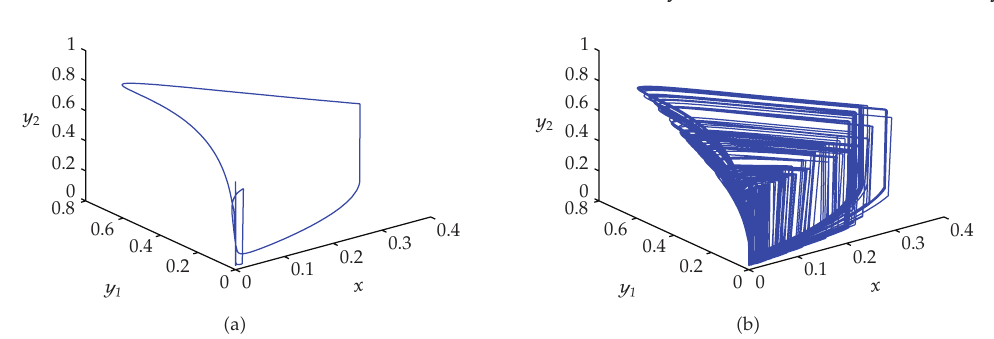
Figure 5: Non-unique attractor at T (cid:6) 15 . 22: (cid:2) a (cid:3) Phase portrait of 3 T -periodic solution with initial values x (cid:6) 8 . 5 , y 1 (cid:6) 4 . 8 , y 2 (cid:6) 2 . 8. (cid:2) b (cid:3) Phase portrait of chaotic periodic solution with initial values x (cid:6) 18 . 5 , y 1 (cid:6) 14 . 8 , y 2 (cid:6) 12 .